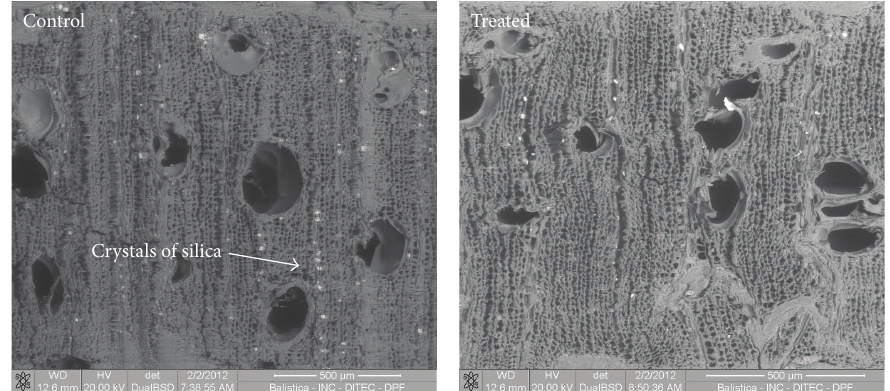
Figure 2: SEM images of the transversal section of the plywood, comparing control and treated samples. Scale: 500 𝜇 m; WD 12.6mm.